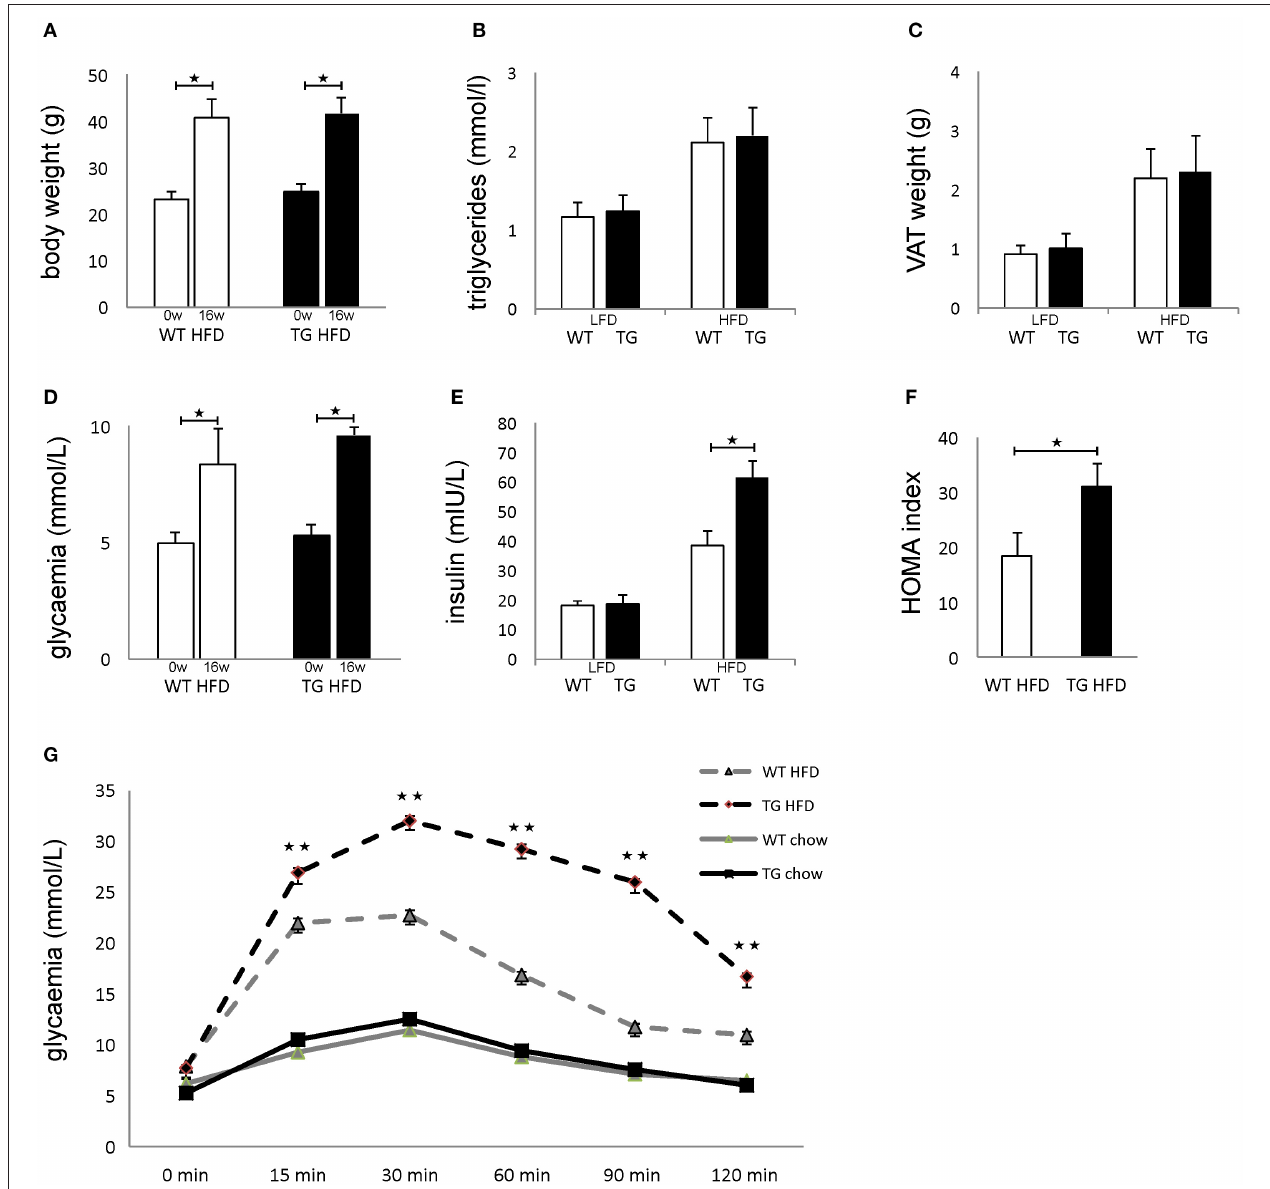
FIGURE 2 | Overexpression of galectin 3 in islets leads to the development of impaired glucose tolerance and insulin resistance in vivo. Body weight at the beginning and after 16 weeks on an HFD regime. Both WT and TG mice showed increased body weight after 16 weeks of HFD (A) . Levels of triglycerides in sera after 16 weeks of LFD and HFD feeding. There was no difference in triglyceride levels in sera between the two groups (B) . Weight of epididymal VAT after 16 weeks on LFD and HFD. There was no difference in the weight of epididymal fat deposits between the two groups (C) . Blood glucose levels after 4h of fasting at the beginning and after 16 weeks on HFD feeding. After 16 weeks of HFD, both WT and TG mice showed increased glycemia after 4h of fasting, but there was no difference between the two groups (D) . Serum insulin levels after 16 weeks and HOMA index. Insulin levels in mice on HFD were significantly higher in TG mice compared to WT mice. The HOMA index was also significantly higher in TG mice on HFD (E,F) . Glucose tolerance test after 16 weeks. Glycaemia at 15, 30, 60, 90, and 120min after glucose application was significantly higher in TG mice on HFD (G) . Blood glucose levels after 12h of fasting. After 16 weeks of HFD, both WT and TG mice showed increased glycemia after 12h of fasting, but there was no difference between the two groups (D) . Data from two experiments with 10–15 mice per group are shown as mean ± SEM; by Mann-Whitney U -test and independent-sample Student’s t -test; * p < 0.05, ** p < 0.01. group, while there were no differences after stimulation with cocktail ( Figure 5B ). Also, galectin 3-overexpression has a the IFN- γ , IL-1 β , TNF- α cocktail ( Figure 5A ). Overexpression prooxidant effect independently of cytokine stimuli, as evaluated of galectin 3 exerted a prooxidant role and increased levels by levels of NO and thiobarbituric acid reactive substances of H 2 O 2 after 24-h stimulation with proinflammatory cytokine (TBARS) ( Figures 5C,D